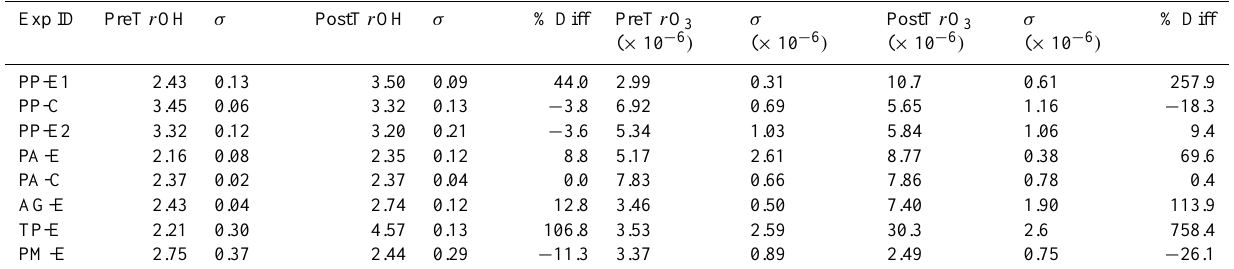
Table 6. Summary of the BVOC pre-treatment (PreT) and post-treatment (PostT) concentration-normalized OH reactivity ( r OH) and concentration-normalized O 3 reactivity ( r O 3 ) at 298 ± 2K. Reactivity values are presented in units of s − 1 . The σ is the standard devia- tion of the averaged measurements. The percent difference between the pre-treatment and post-treatment values is also